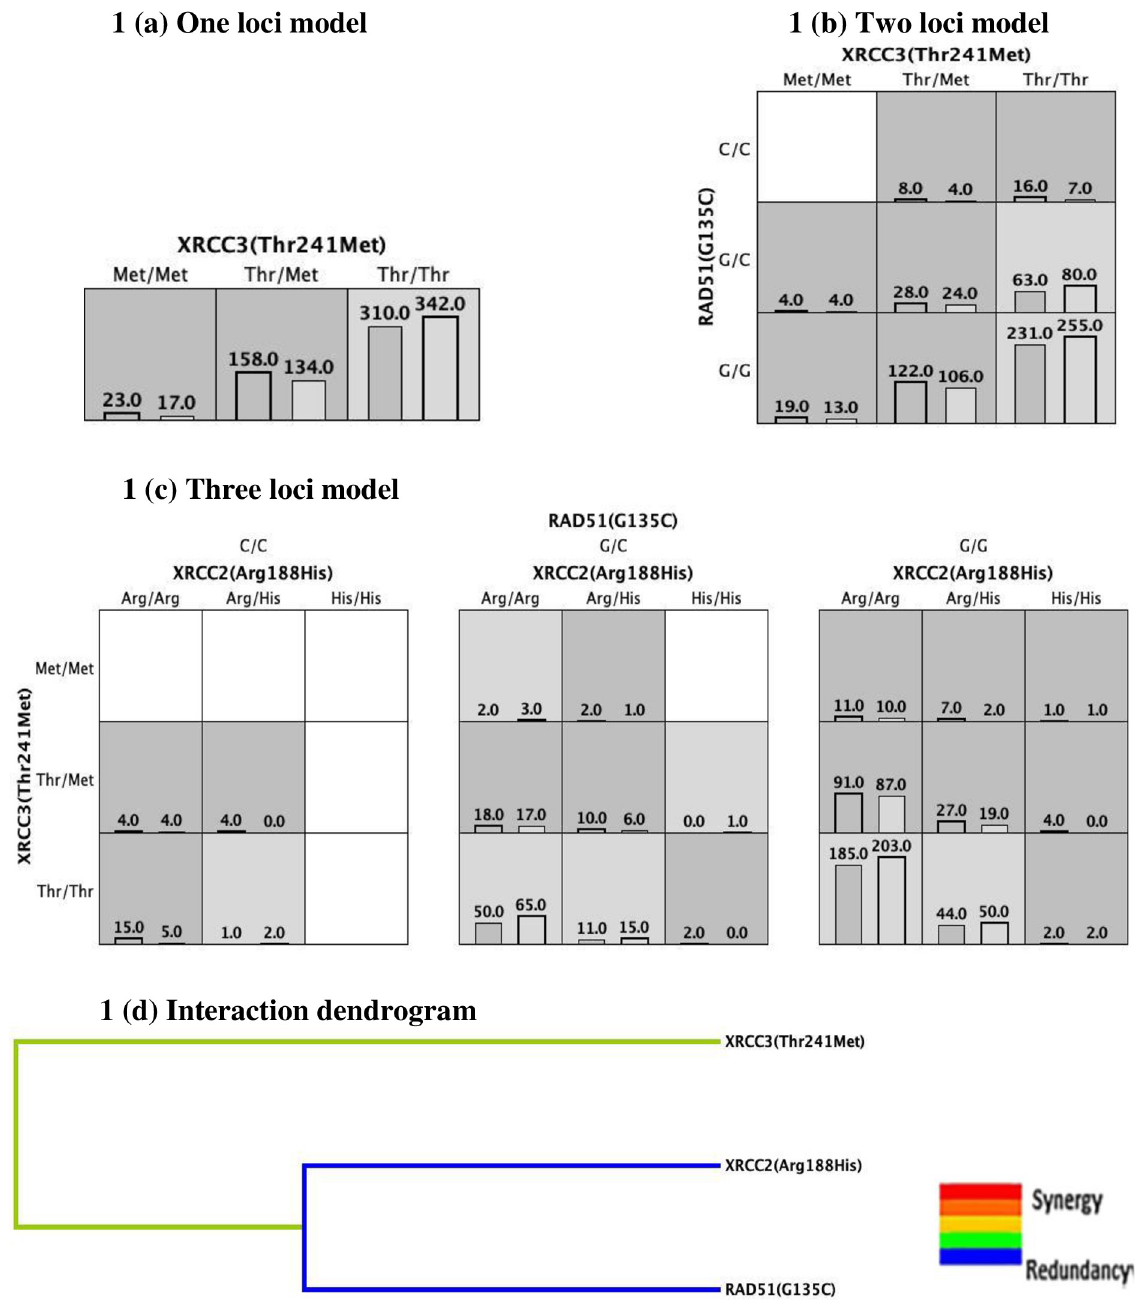
Fig 1. MDR analysis. Each cell depicts the number of BC cases on the left and the number of controls on the right. A high-risk genotype combination is given in dark grey cells, and a low-risk genotype combination is given in light grey cells. (a) Single-loci model representing cases and controls based on XRCC3 (Thr241Met) variant, (b) two-loci model depicting cases and controls classified based on two SNPs ( XRCC3 -Thr241Met and RAD51 –G135C), (c) three-loci model depicting cases and controls classified based on three SNPs, (d) interaction dendrogram revealed that the investigated HRR variants were found to have a redundant effect on BC